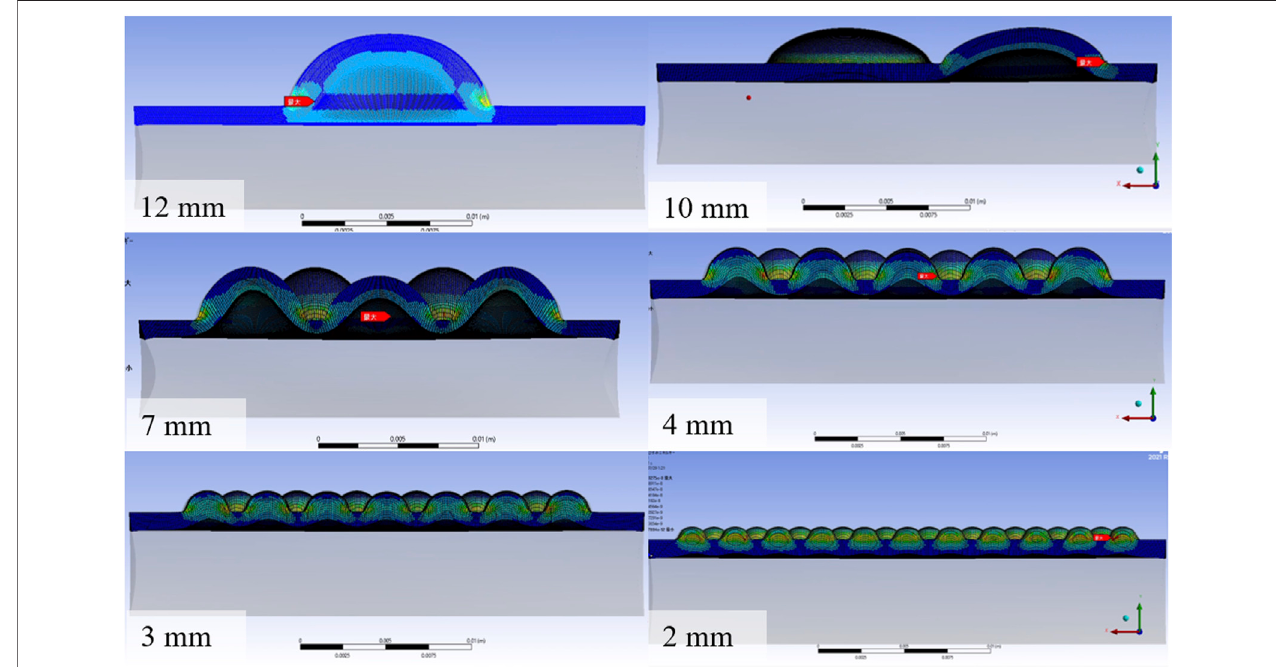
FIGURE11| Cross-sectionalviewofthestrainenergysimulationresultsforeach suctiondiameter.Apressureof − 600 hPawasappliedtothesuctionpointonthe skin surface. Only the dermis part is shown.